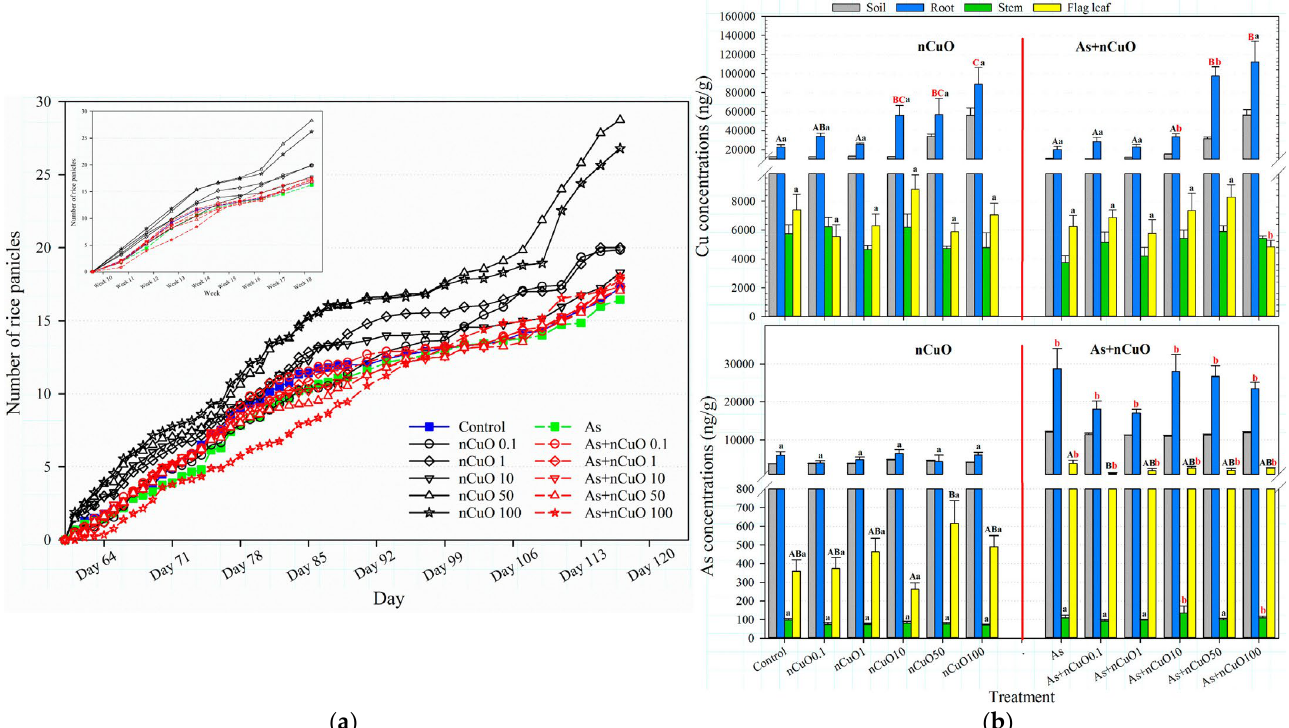
Figure 6. ( a ) Heading process of rice panicles after 131 days of exposure to arsenic in soil and copper oxide nanoparticles in the nutrient solution. Reprinted with permission from Ref. [57]. 2018, American Chemical Society; ( b ) copper and arsenic concentrations in the mature rice plants from a greenhouse study of rice ( O . sativa japonica ‘Koshihikari’) with 131-day exposure to arsenic in soil and copper oxide nanoparticles in the nutrient solution. Means of treatments at the same As level with a common superscript letter (A–C) are similar ( p < 0.05). Means of treatments at the same CuO NPs level with a common superscript (a and b) letter are similar ( p < 0.05). Reprinted with permission from Ref. [58]. 2019, American Chemical Society.